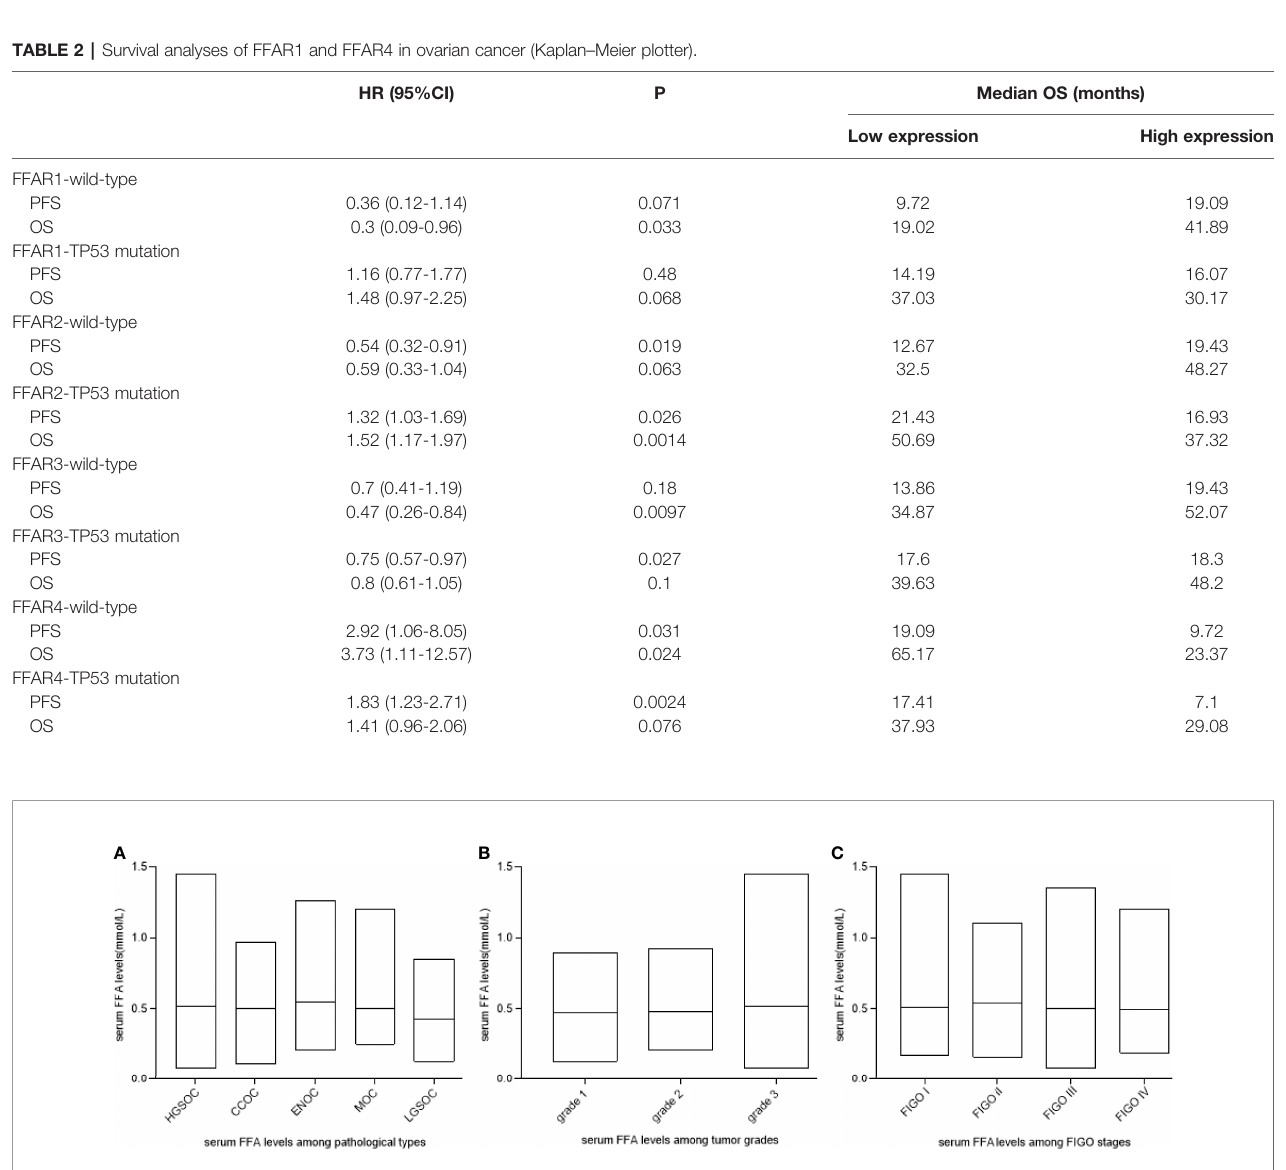
FIGURE 1 | FFA levels among OC patients with different pathological types, stages and grades. (A) FFA levels among pathological types (P > 0.05). (B) FFA levels among tumor grades (P > 0.05) (C) FFA levels among FIGO stages (P > 0.05). HGSOC, high-grade serous ovarian cancer (HGSOC); ENOC, endometrioid ovarian cancer; CCOC, clear cell ovarian cancer; MOC, mucinous ovarian cancer; LGSOC, low-grade serous.